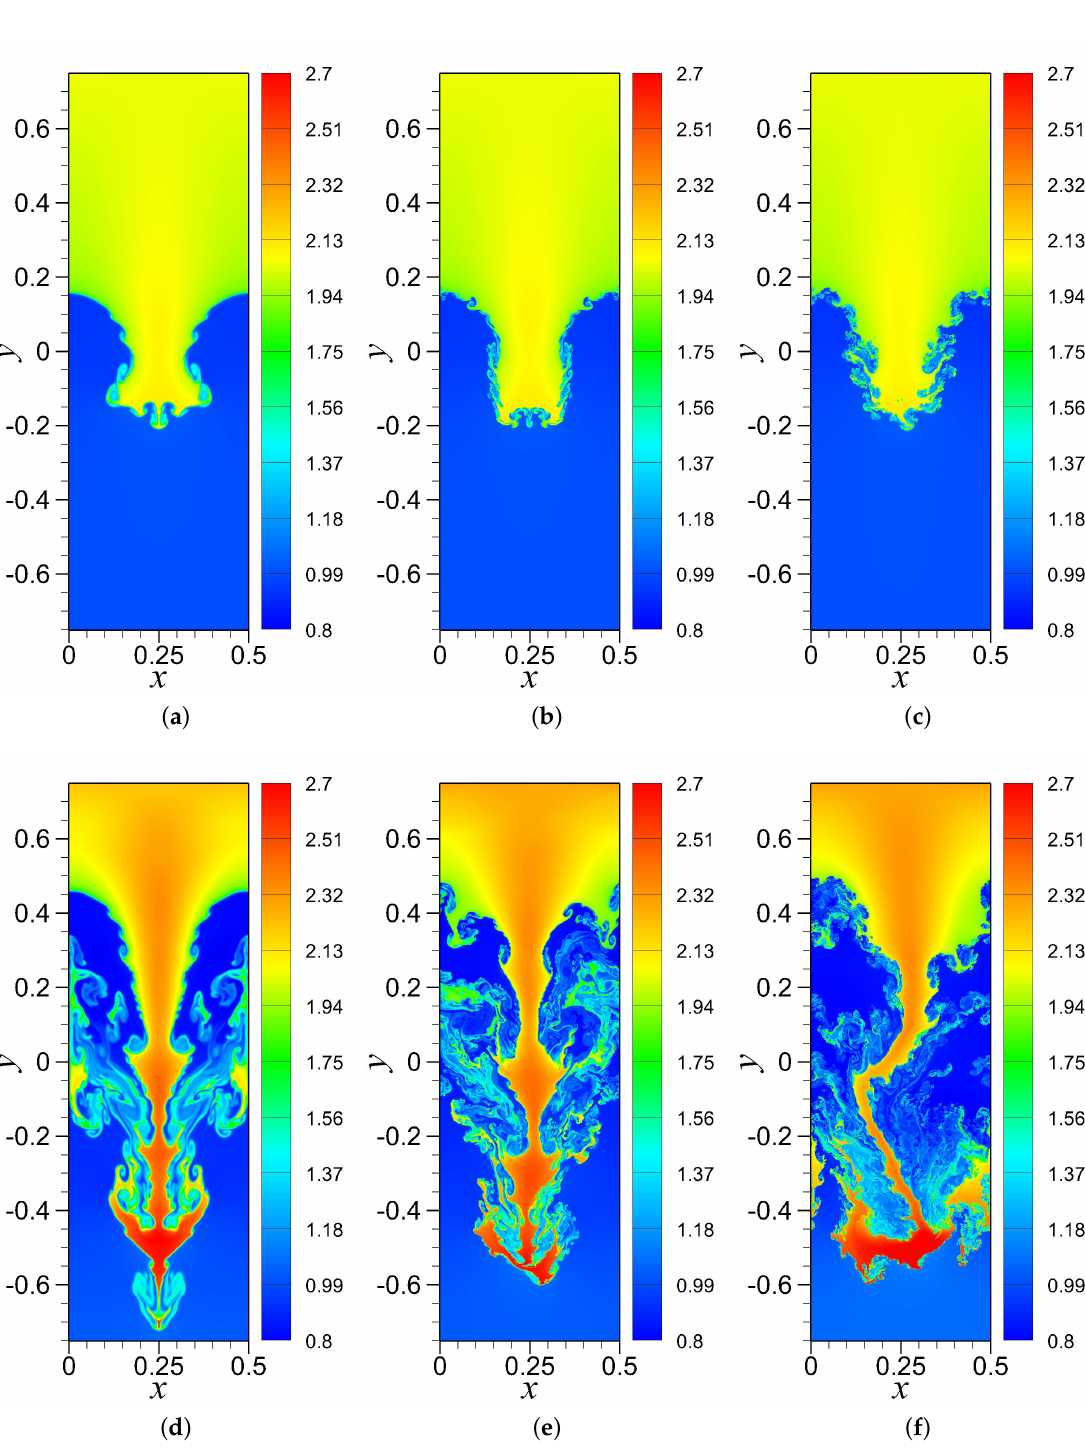
Figure 15. Time evolution of density field for the RTI problem with single-mode perturbation for different coarse grid resolutions using ILES-Roe scheme: ( a ) ILES-Roe with 256 × 768 resolution at t = 2.7; ( b ) ILES-Roe with 1024 × 3072 resolution at t = 2.7; and ( c ) ILES-Roe with 4096 × 12288 resolution at t = 2.7; ( d ) ILES-Roe with 256 × 768 resolution at t = 4.5; ( e ) ILES-Roe with 1024 × 3072 resolution at t = 4.5; and ( f ) ILES-Roe with 4096 × 12288 resolution at t = 4.5. The gravity is directed in a vertically downward